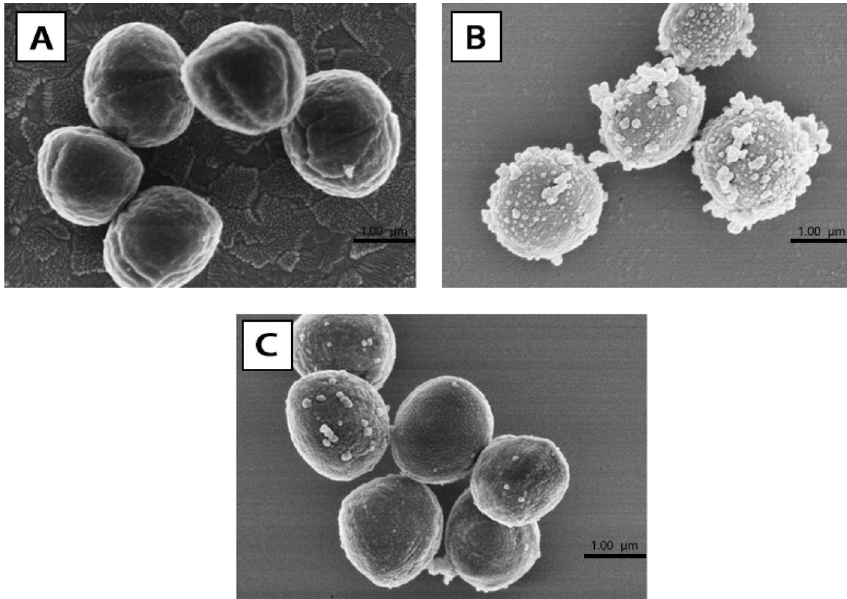
Figure 4. Morphological structure of S. aureus observed by SEM, untreated ( A ); VTE treatment 12 h ( B ); DMY treatment 12 h ( C ).